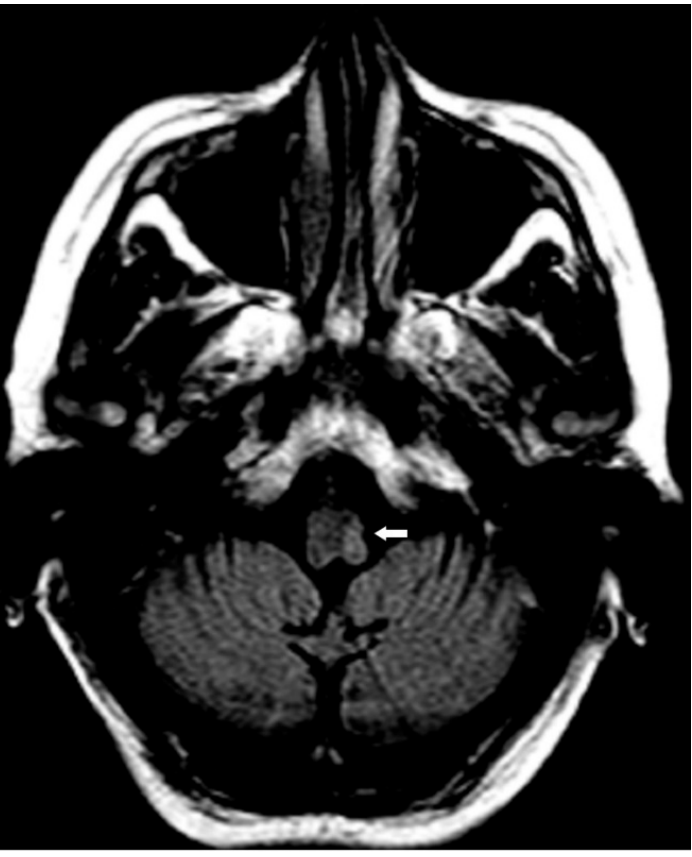
Figure 1. An axial FLAIR-weighted MRI image showing a hyperintense area (white arrow) in the left lateral medulla, suggestive of infarct. Figure 2. Multiple hyperkeratotic nodules on the right side of the head ( A ), the right upper limb ( B ), and the right upper trunk ( C , D ) before dupilumab treatment.